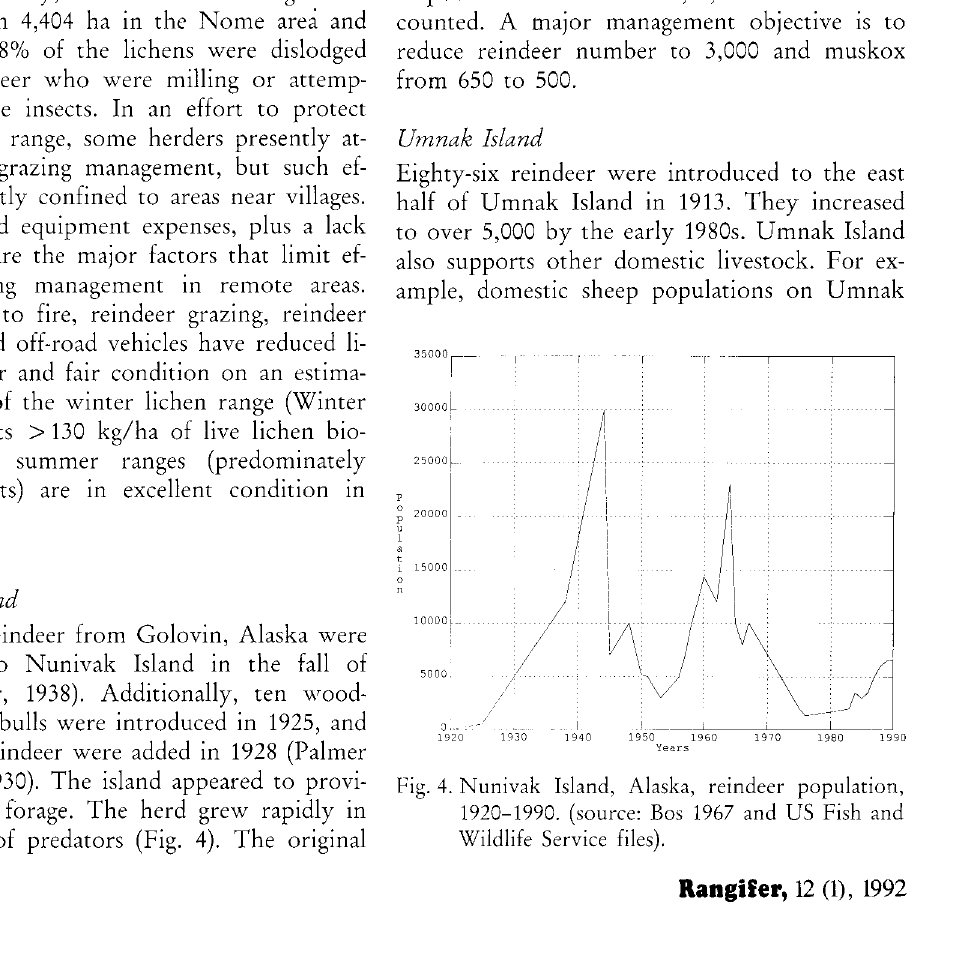
Fig. 4. Nunivak Island, Alaska, reindeer population, 1920-1990. (source: Bos 1967 and US Fish and Wildlife Service